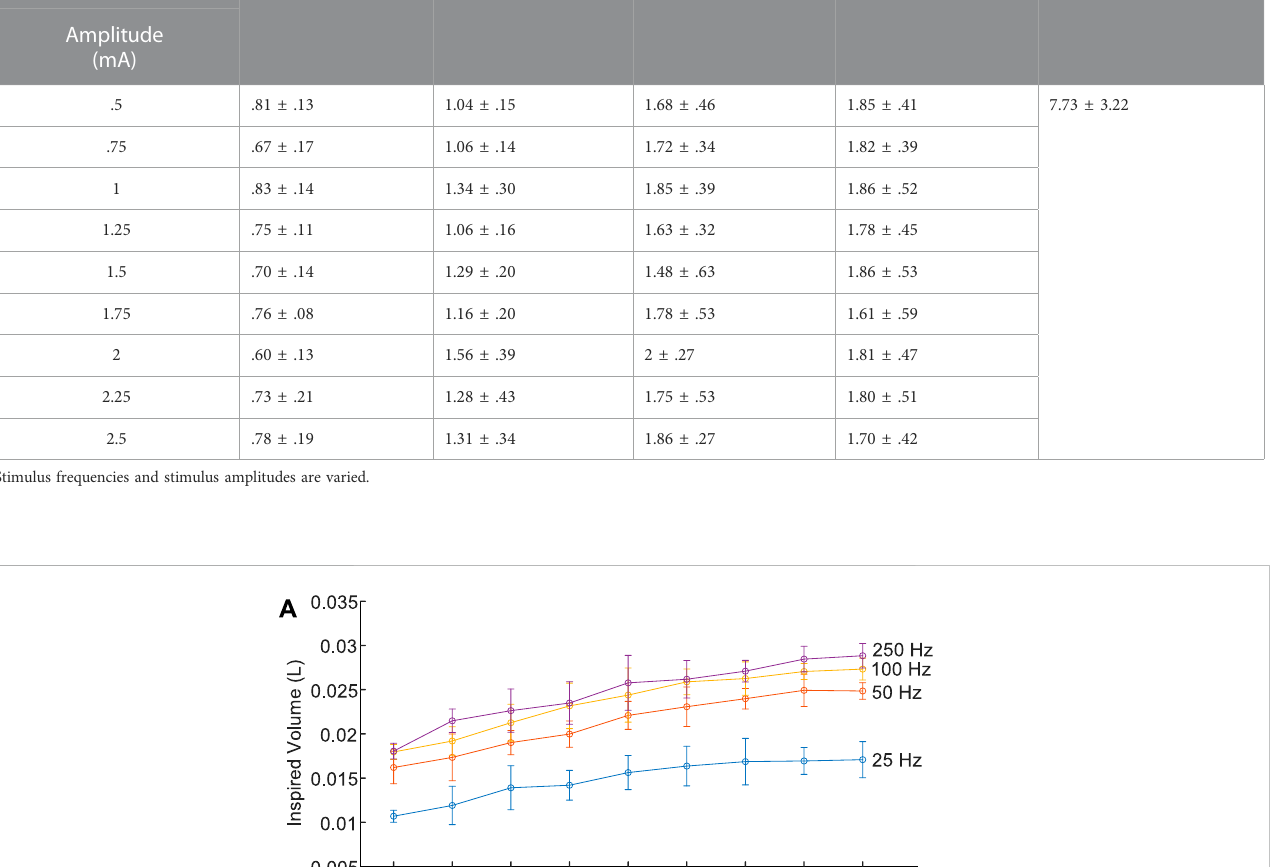
inspiratory air fl ow curve well under all conditions (DP and anesthesia). The air fl ow curve was not smooth due to individual contraction of the diaphragm at the stimulus frequency of 25 Hz, but the line fi tted by the power equation could accurately re fl ect downward concavity of inspiratory air fl ow. For each stimulus frequency of DP, little